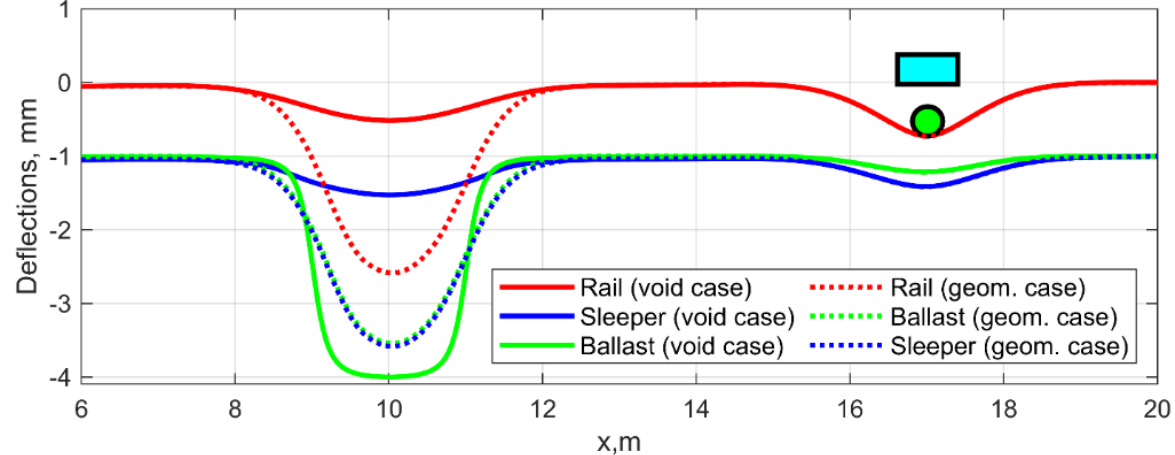
Figure 4. Elastic deformations of beam elements for the void and equivalent geometrical irregularity.